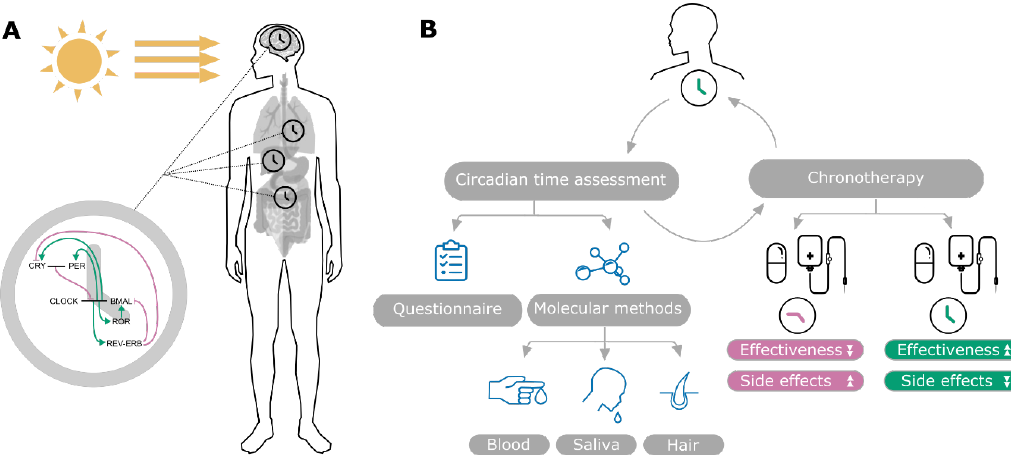
Figure 1. Circadian clock main components and the interplay between circadian time assessment and chronotherapy. ( A ) The internal clock is composed of central and multiple peripheral clocks, sharing a common molecular network of transcription/translation feedback loops. ( B ) Multiple methods are used to assess internal circadian rhythms including chronotype evaluation questionnaires and various biological samples that can be collected to assess hormonal concentration and gene expression profiles. Time-of-day treatment adjustment in alignment with the internal circadian clock of the body has been reported to increase effectiveness and decrease toxicity of treatment.